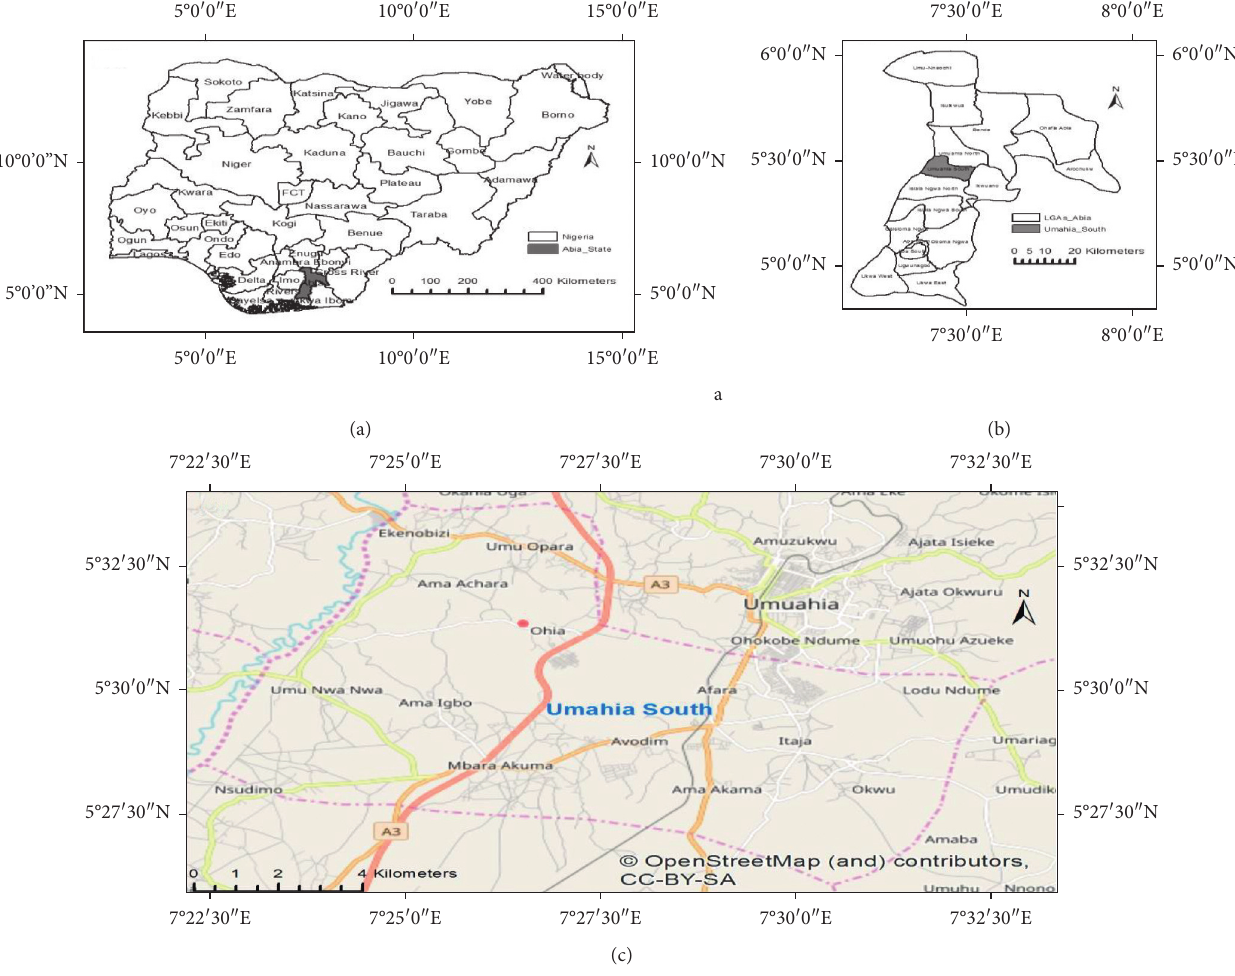
Figure 1: Location map of borrow pit